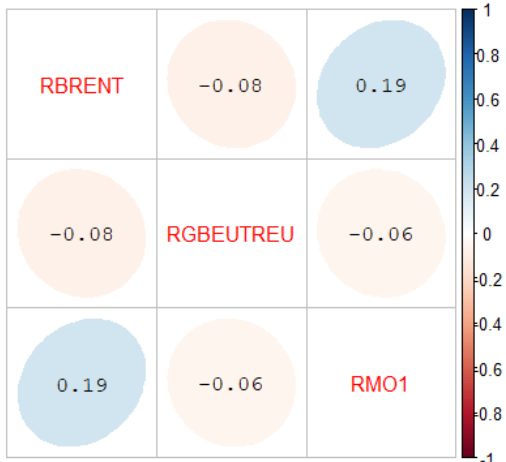
Figure 5. Unconditional correlation for Brent oil returns (RBRENT), Green Bond Index (RGBEUTREU), and CO 2 futures’ returns (RMO1). Source: Authors’ own research using data from Bloomberg.